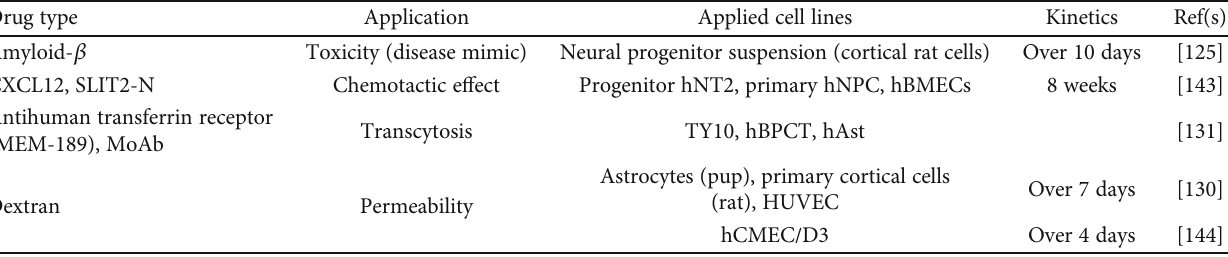
Table 7: Summary of recent advancements in in vitro models in brain toxicity testing including the type of drug, the application, the applied cell lines, and the